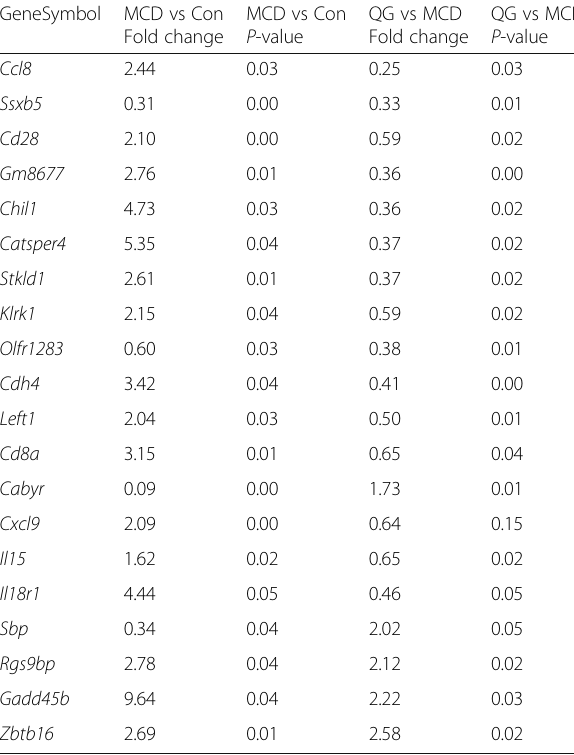
Table 3 Representative overlapped differentially expressed genes Table 4 Representative differentially expressed lncRNAs